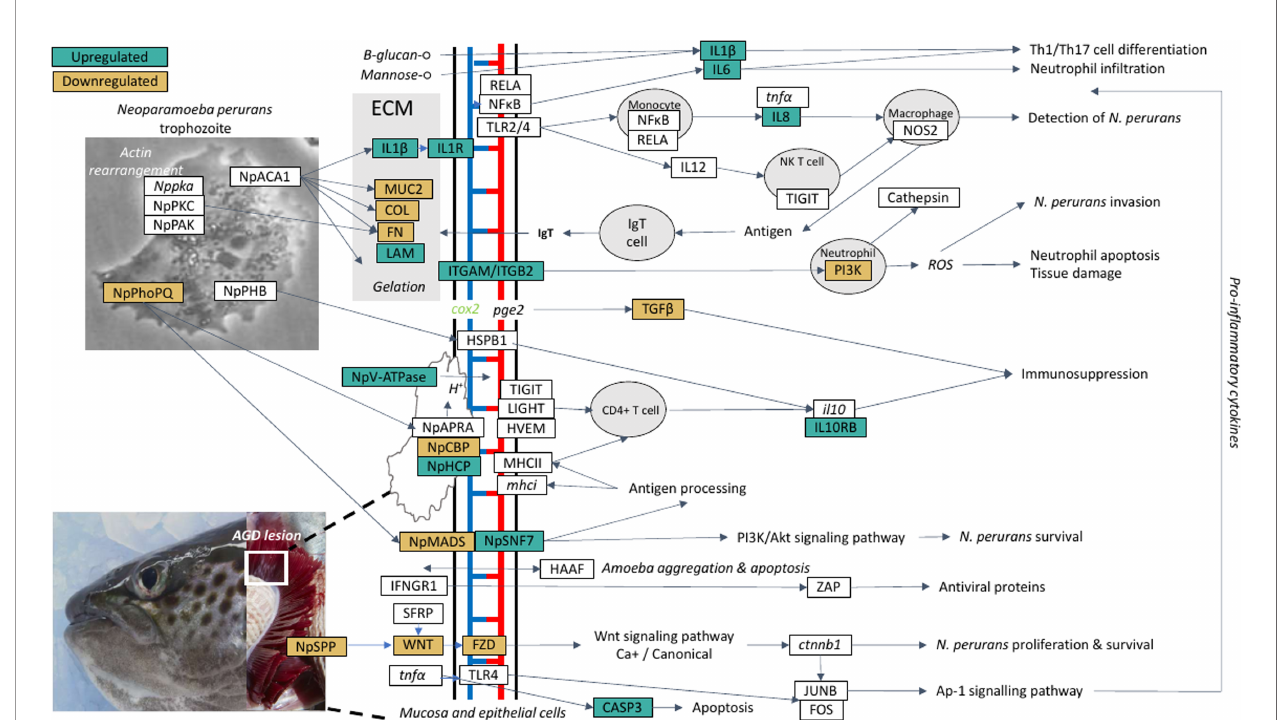
FIGURE 5 | A theoretical model for the host-parasite interaction between Neoparaomoeba perurans candidate genes and Atlantic salmon during the pathogenesis of amoebic gill disease (AGD). The pathway was generated from the differential gene expression and network analyses together with the key KEGG pathways mapped and visualized (sasa04310, sasa05168, sasa05132, hsa04151, hsa05146) for the host and the parasite. Pathogen invasion is facilitated by degradation of host mucus and epithelia. To maintain a pathogen friendly environment on the gill N. perurans releases factors to decrease ammonia and reactive oxygen species released by the host. Actin rearrangement of the pathogen and the host facilitates attachment. Virulence factors are modulated by the pathogen master two component PhoPQ virulence regulatory system. Downregulation of the host wnt, Ap-1 and PI3K/Akt signaling pathways supports pathogen immune evasion, proliferation, and survival. The Th1/17 cell differentiation pathway is upregulated inducing innate and adaptive immune responses in the host. NP signi fi es N. perurans genes, upregulated genes are green, downregulated brown, not differentially expressed are white, italicized genes were not identi fi ed in our dataset. CASP3, caspase-3 ; COL, collagen (various); cox2 , cyclooxygenase 2 ; ctnnb1 , b -catenin ; FN, fi bronectin ; FOS, fos ; FZD, frizzled ; HAAF, hemagglutinin/amebocyte aggregation factor-like ; HSPB1, heat shock protein beta-1-like ; HVEM, tumor necrosis factor receptor superfamily ; IFNGR1, interferon gamma receptor 1 ; il10 , interleukin 10 ; IL10RB, interleukin-10 receptor subunit beta-like ; IL12, interleukin-12 ; IL1R1, interleukin-1 receptor type 1-like ; IL1 b , interleukin-1 beta ; IL6, interleukin- 6 ; IL8, interleukin 8 ; ITGAM, integrin alpha-X-like ; ITGB2, integrin beta-2 ; JUNB, junb ; LAM, laminin ; LIGHT, tumor necrosis factor ligand superfamily ; mhci , major histocompatibility complex class I ; MHCII, major histocompatibility complex class II ; MUC2, mucin-2-like ; NF k B1, nuclear factor NF- k - b p105 subunit-like; NOS2, nitric oxide synthase 2; Np ACA1, prokumamolisin activation domain containing protein ; Np APRA, AprA protease ; Np CBP, cathepsin-B ; Np HCP, hybrid cluster protein ; Np MADS, MADS-box transcription factor ; Np PHB, prohibitin ; Np PhoPQ, PhoPQ-activated pathogenicity-related protein ; Np SNF7, vacuolar sorting protein SNF7 ; Np SPP, signal peptide peptidase ; Np V-ATPase, vacuolar proton ATPase ; Np PAK, p-21 activated kinase ; Nppka , protein kinase A ; Np PKC, protein kinase C ; pge2 , prostaglandin E2 ; PI3K, phosphatidylinositol 3 ’ -kinase ; RELA, putative transcription factor p65 homolog ; SFRP, secreted frizzled-related protein; TGF b , transforming growth factor beta ; TIGIT, T-cell immunoreceptor with Ig and ITIM domains ; TLR2/4, toll-like receptor 2 and 4 ; tnfa , tumor necrosis factor alpha ; WNT, protein Wnt ; ZAP, zinc fi nger antiviral